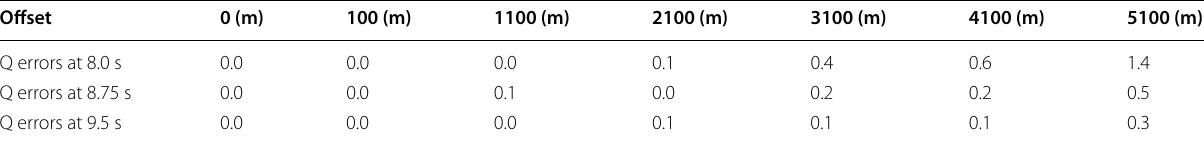
Table 1 Percentage errors in Q estimation caused by frequency distortion at NMO correction